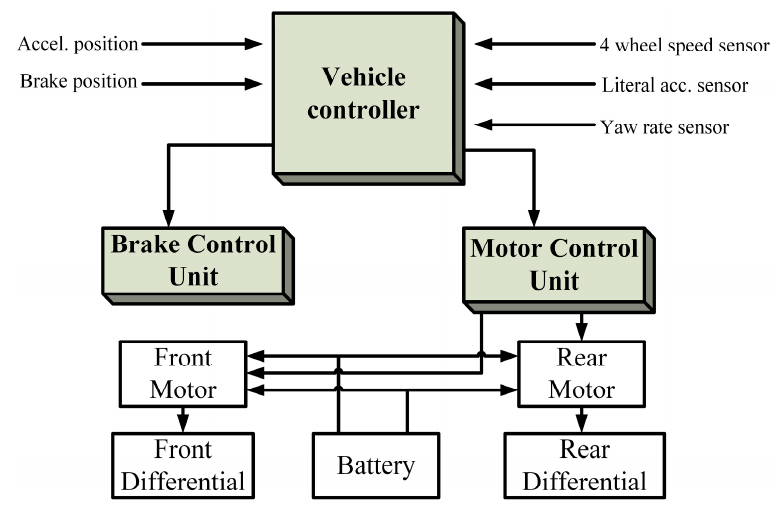
Figure 25. Structure for four-wheel drive HEV [32]. This particular system uses a vehicle controller which employs a number of sensors to perceive the driving condition and keeps the vehicle stable by controlling the brake control and the motor control units.